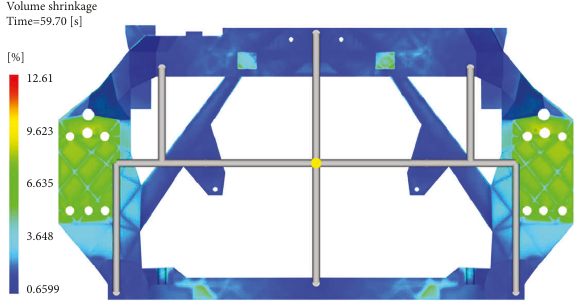
Figure 17: Acloud map of minimum volume shrinkage.